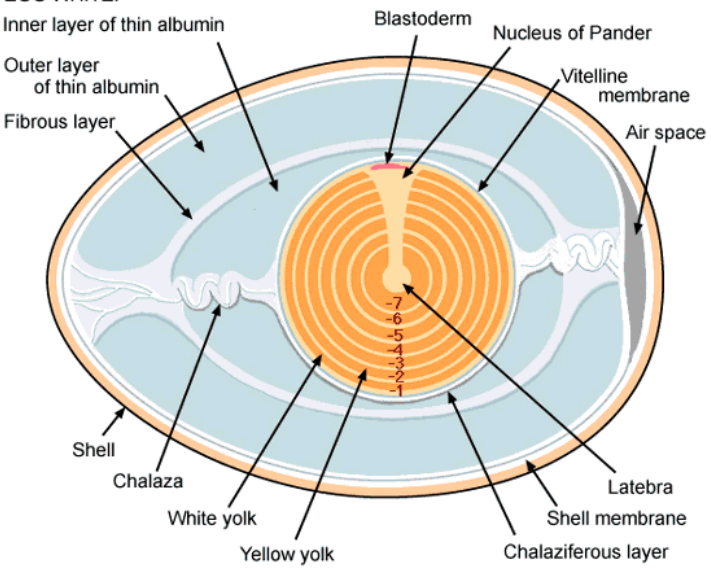
Figure 2. Chicken egg structure.